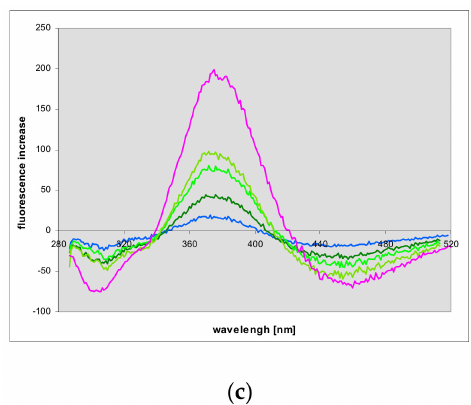
Figure 11. Changes in fluorescence excitation ( a ) and emission spectra ( b ), observed during the titration of E. coli PNP with 1,N 6 -etheno-tubercidine ( 6 ). Emission spectra were recorded with excitation at 280 nm, excitation spectra were observed at 380 nm. Conditions: 40 mM phosphate bu ff er, pH 7, at 20 ◦ C. The concentration of protein was 11 µ M per subunit; that of 1,N 6 -etheno-tubercidine was (0–18.5 µ M). Black curves refer to pure protein emission or excitation (observed at 310 nm); ( c ) fluorescence di ff erence spectra of 11 µ M E. coli PNP, titrated with 1,N 6 -etheno-tubercidine (1.9, 3.7, 5.4, 7.1 and 18.5 µ M), calculated from data in panel ( b ).